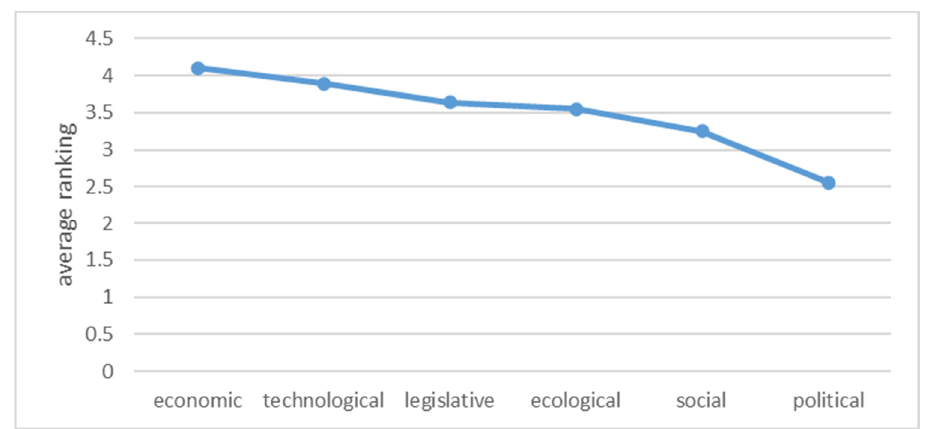
Figure 2. Results of the Wilcoxon test: Evaluation of the significance of influences from the external environment (Source: own research).